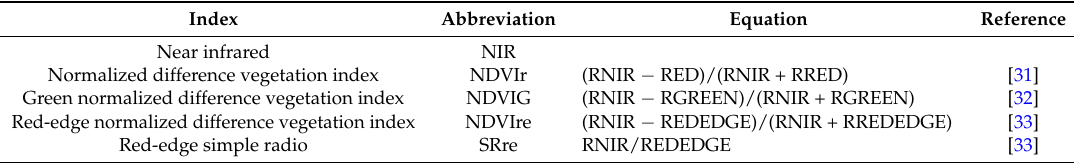
Table 2. Description, acronym, equations, and references for all vegetation indices (VIs).